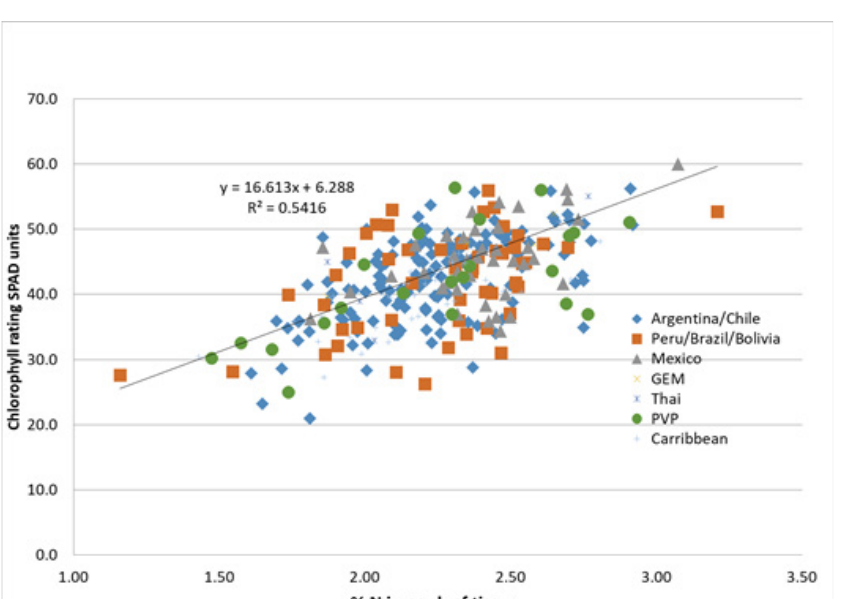
Figure 8: Relationship between N content of ear leaves and chlorophyll scores for 334 inbred lines grown under N-limited conditions in 2014